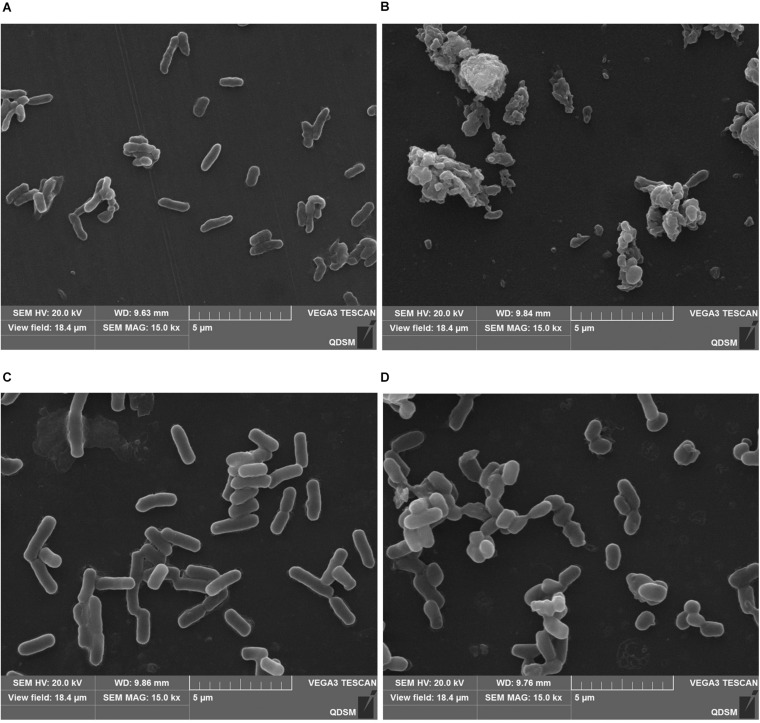
Scanning electron microscopic (SEM) images showing effect of GOxP5 on L. monocytogenes
(B) and V. parahemolyticus
(D). (A,C) represents the blank control.